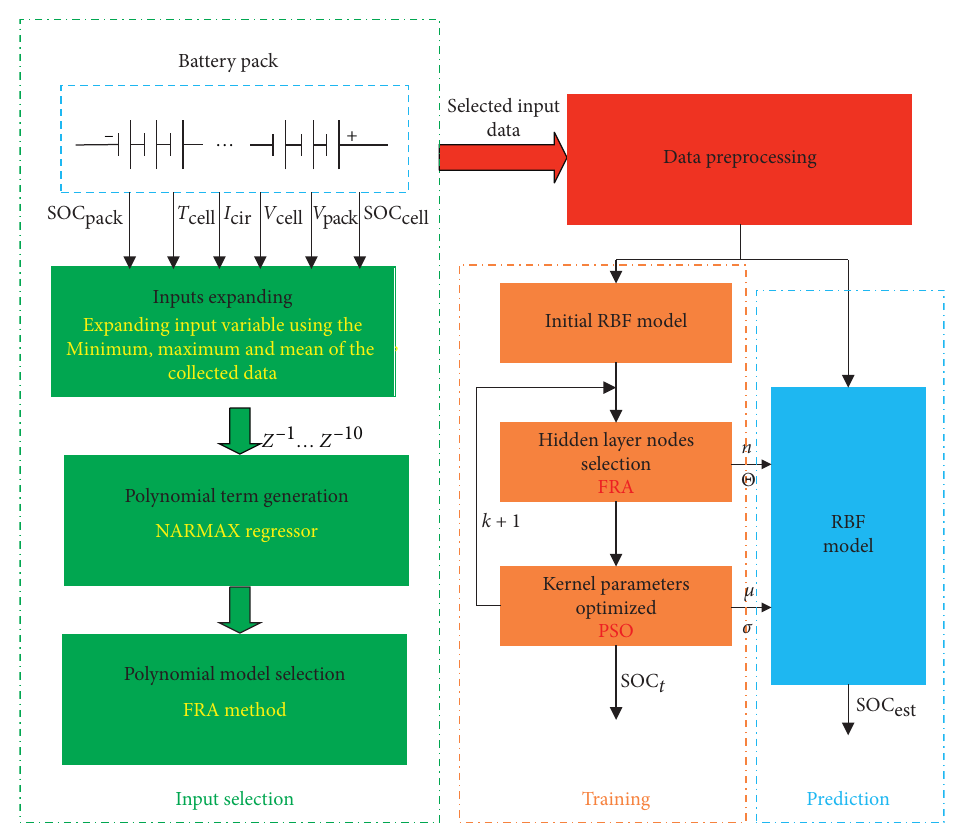
Figure 1: The flowchart of the battery pack SOC